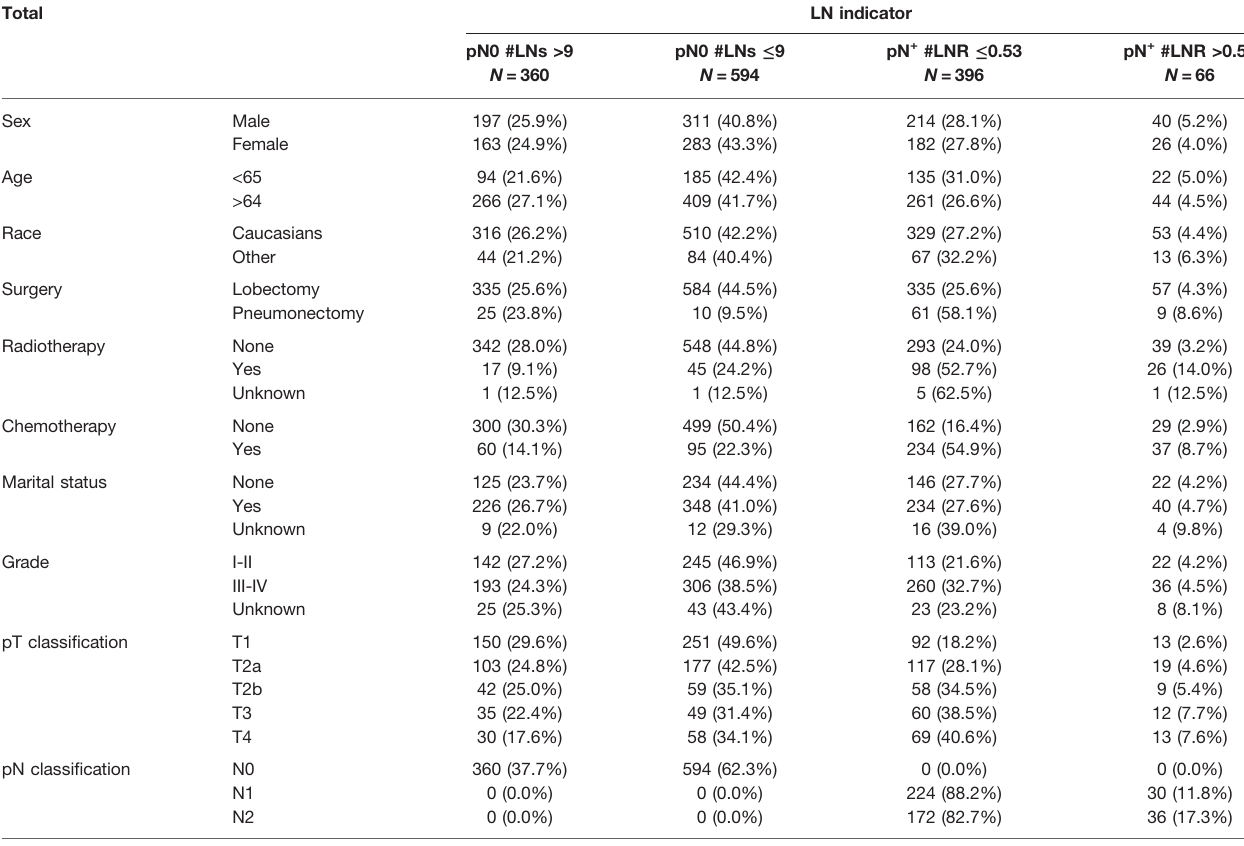
TABLE 1 | The characteristics of adenosquamous carcinoma